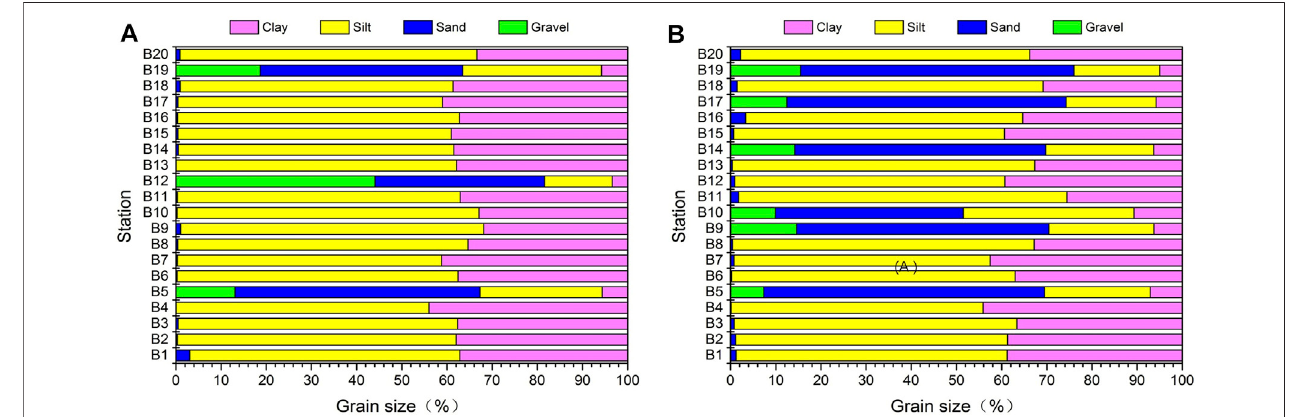
FIGURE 2 | The grain size of surface sediment in Daya Bay in spring (A) and autumn (B) .